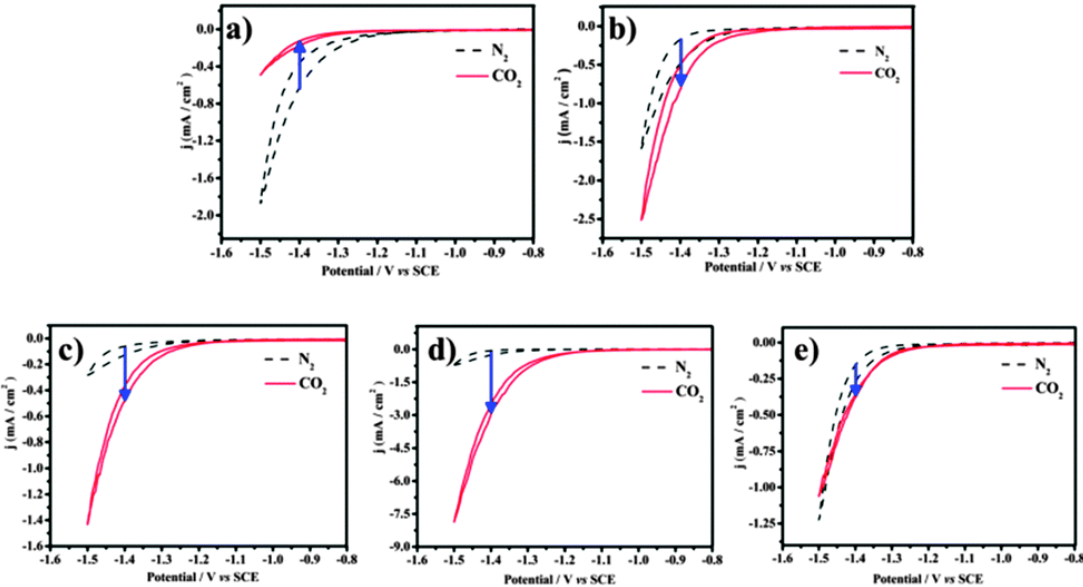
Figure 4. The cyclic voltammograms of catalysts were recorded in N 2 - and CO 2 -saturated 0.5 M KHCO 3 with a scan rate of 10 mV/s −1 between −0.8 and −1.5 V (vs. SCE). ( a ) Cu-Pt-1#, ( b ) Cu-Pt-2#, ( c ) Cu-Pt-3#, ( d ) Cu-Pt-4#, and ( e ) Cu-Pt-5#. Reprinted from Ref. [110], copyright (2015), with permission from the Royal Society of Chemistry.